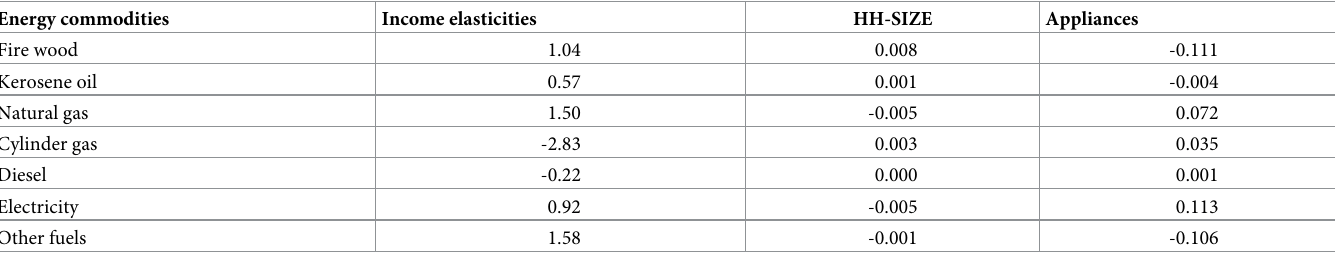
Table 8 presents the income elasticity of LA-AIDS and demographic parameters. Estimated income elasticities for Firewood, natural gas, and other fuels are positive and greater than one implies that these items are normal and luxury, while income elasticities for kerosene oil and electricity are positive and less than one indicates that these are normal and necessity items, but Cylindrical gas and Diesel are negative which indicates that these items are inferior. Com- pared to the findings of [21] who reported that all fuel items are necessities for rural house- holds while the negative sign for other fuels, Kerosene oil and firewood for urban areas shows inferior items. Household size has a positive coefficient for Firewood, Kerosene oil, and Cylin- der gas. Estimate for Diesel shows that the usage of these products will increase as the size of the family rises, While the size of the family is negative for natural gas, other fuels and electric- ity, showing that as the size of the family rises than the consumption of these products decreases [4], the same outcomes were also recorded for the size of the family. The coefficient of appliances is significant and positive for Electricity, Natural gas, and Cylinder gas which indicates that when the number of particular appliances increases then the consumption for these items will increase, while appliances are significant but have a negative coefficient for Fire-wood, Kerosene oil and for other fuels which shows when appliances increases than con- sumption for these items will decrease [3], also reported the same results for appliances. various energy items from different models are presented in Table 9. The income elasticities of all the commodities are almost same except firewood as shown in graph that firewood has positive elasticity but less than one shows normal and necessity in log-log model while in LA-AIDS firewood elasticity is greater than one shows luxury item [15], also reported that fire- wood is normal and necessity while [6, 18] reported that firewood is inferior for urban and necessity for rural areas. Kerosene oil is normal and necessity for LA-AIDS and log-log model Table 8. LA-AIDS income elasticities and demographic parameters. Energy